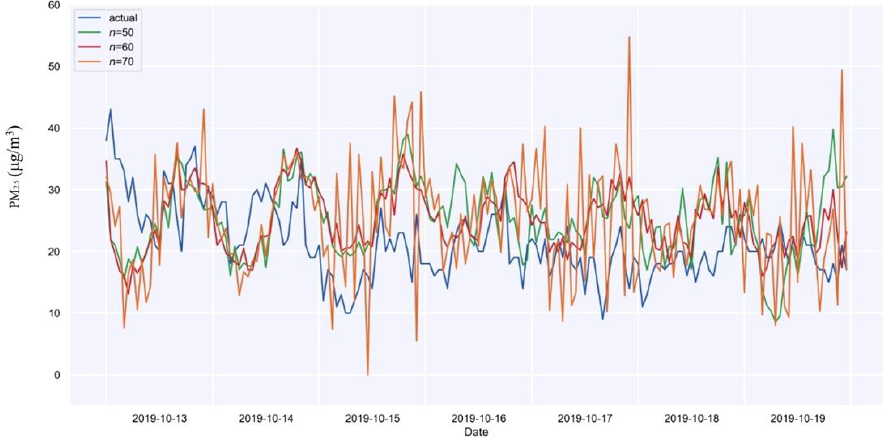
Figure 6. Illustration of PM 2.5 series approximation by using the Fourier polynomial of degree n equivalent to 50, 60, and 70, respectively.